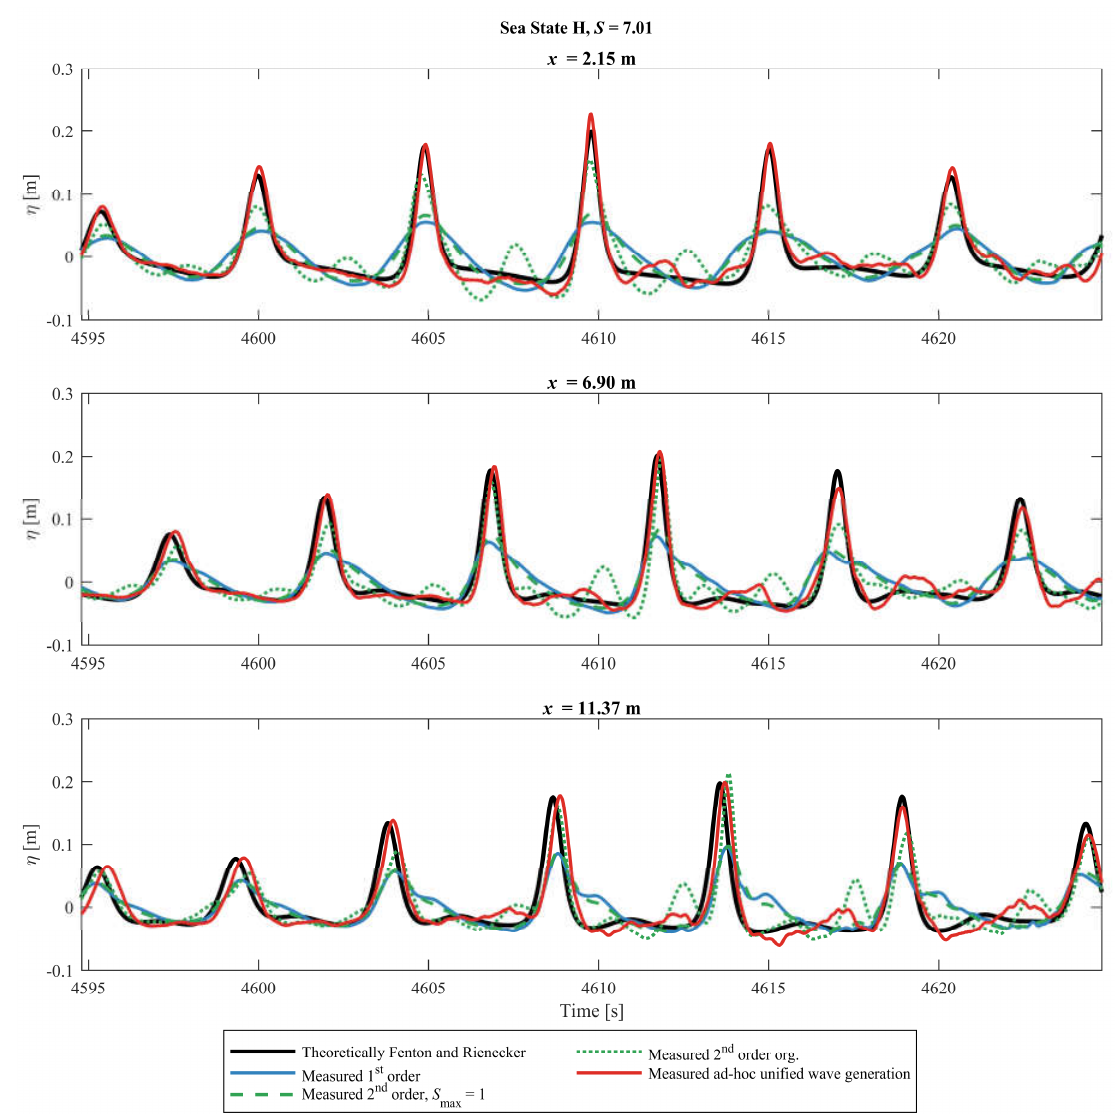
Figure 13. Numerically surface elevation compared with the first-order, second-order, modified second-order and the ad-hoc unified wavemaker methods for Sea State H.